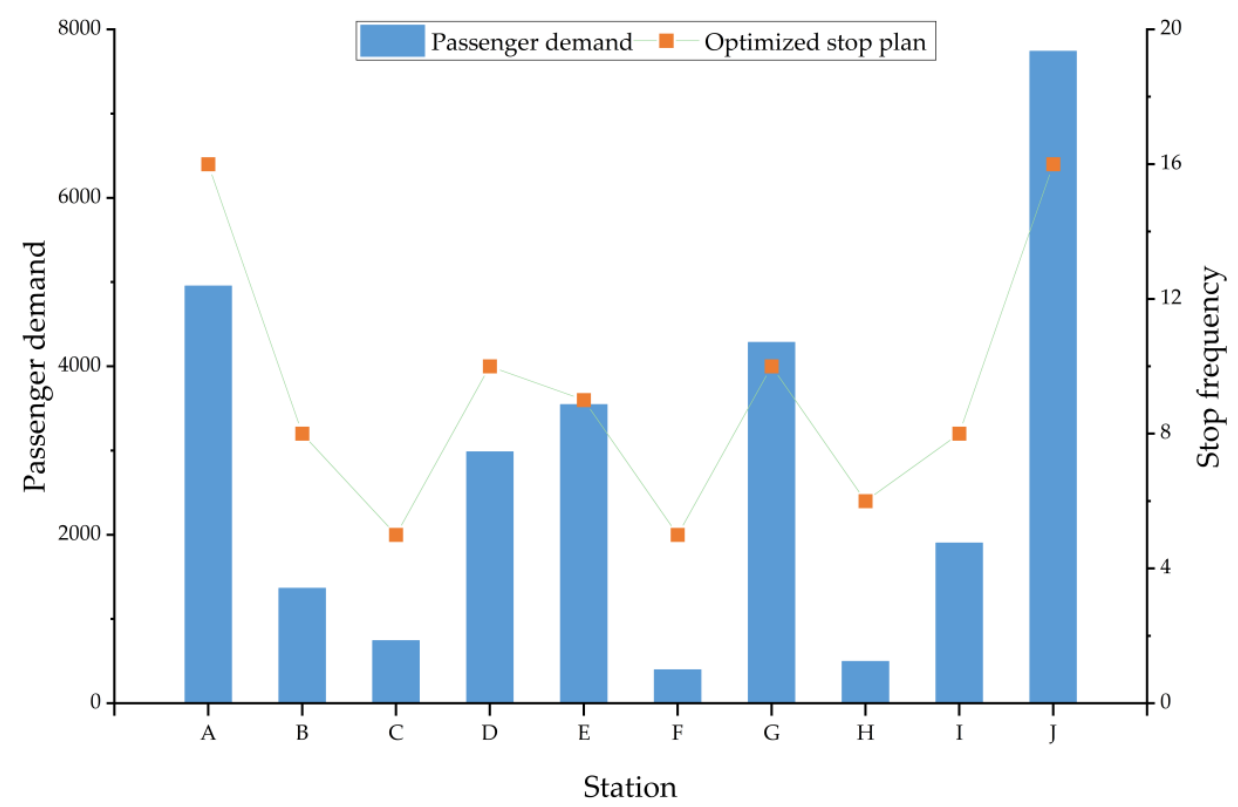
Figure 6. Relationship between stop frequency and passenger demand.